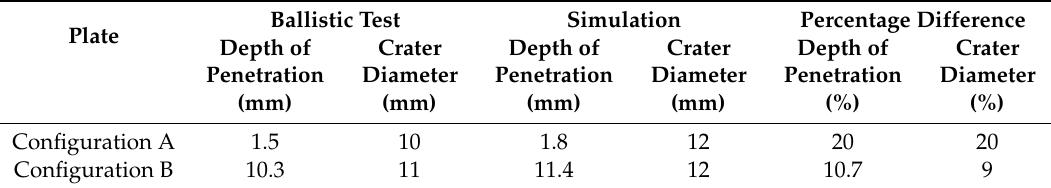
Table 6 . Comparison between ballistic test and simulation results for depth of penetration and crater diameter.